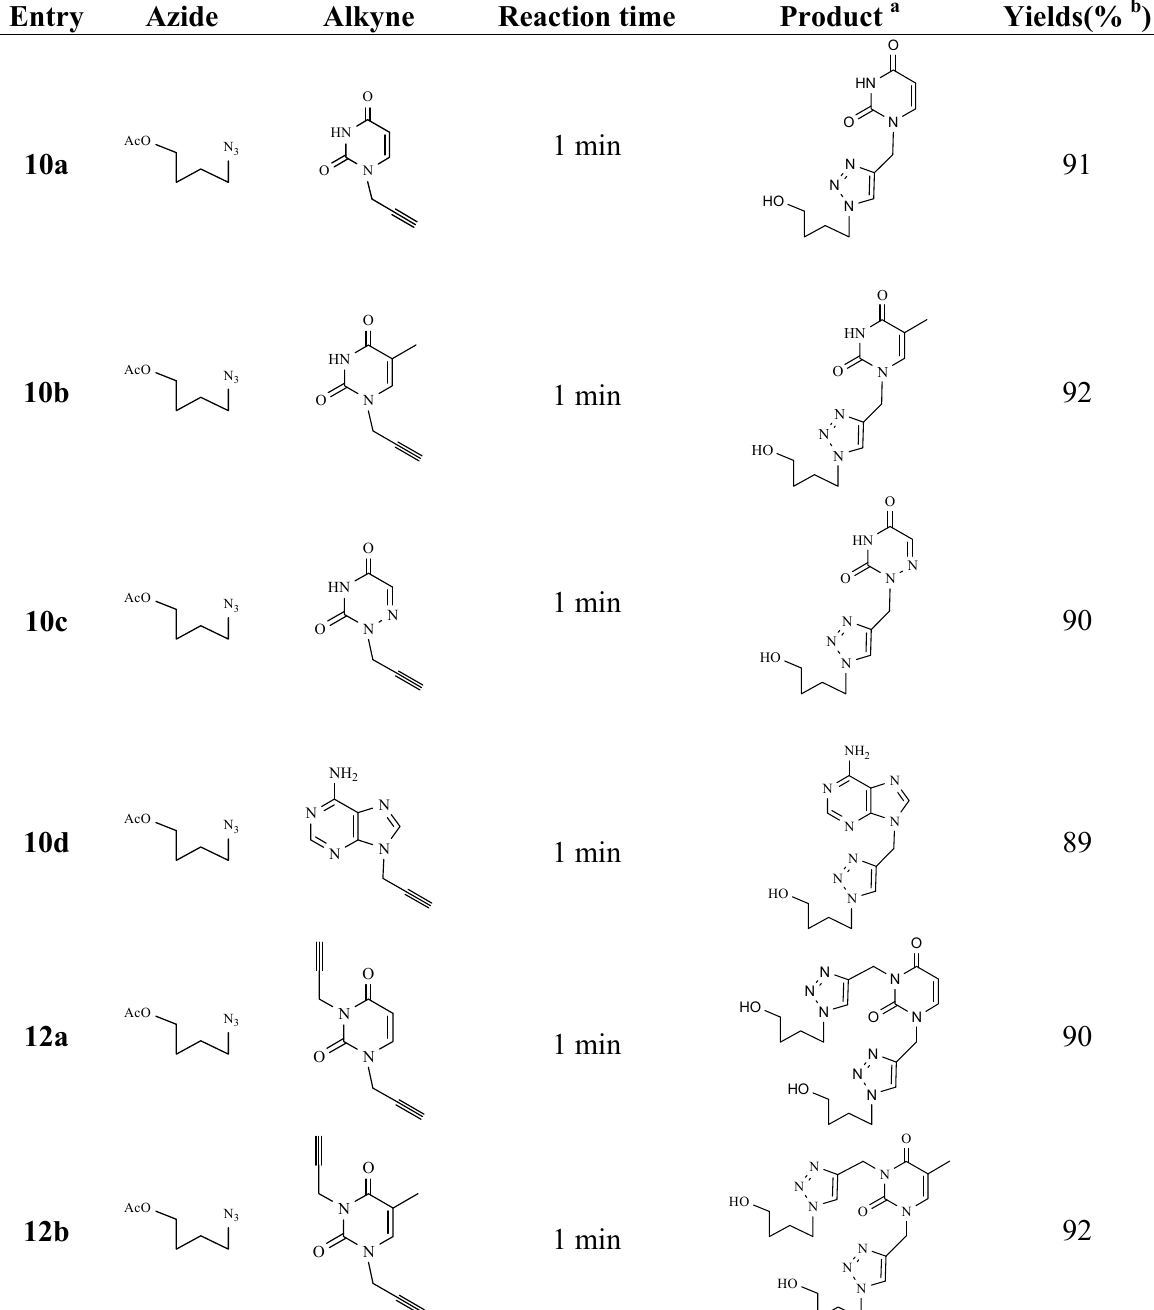
Table 1. Structures of the starting azides, alkynes and corresponding